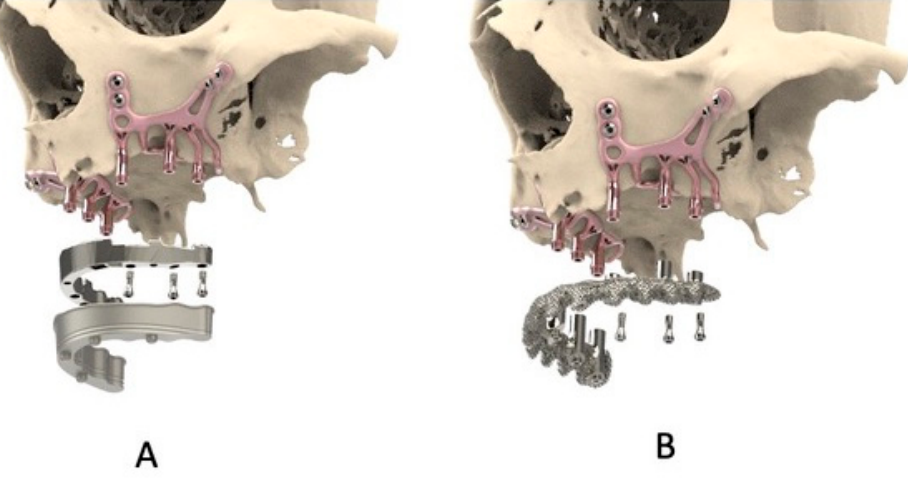
Figure 1. Visualization of the left and right AMSJI system and the connecting suprastructure. ( A ) The suprastructure is a 3D-printed titanium scaffold of a hybrid bridge. ( B ) The suprastructure consists of a double structure of an overdenture.